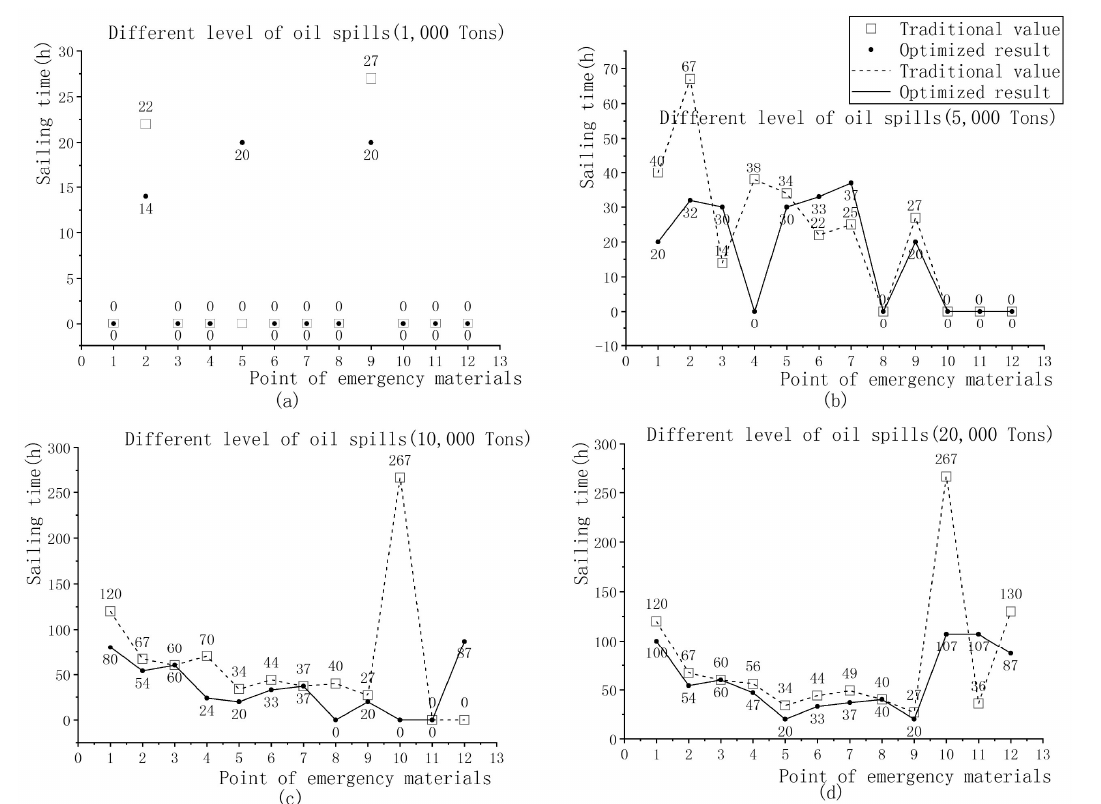
Figure 2. Thecomparison of the amount of emergency materials shipment with the demand (in m 3 ).